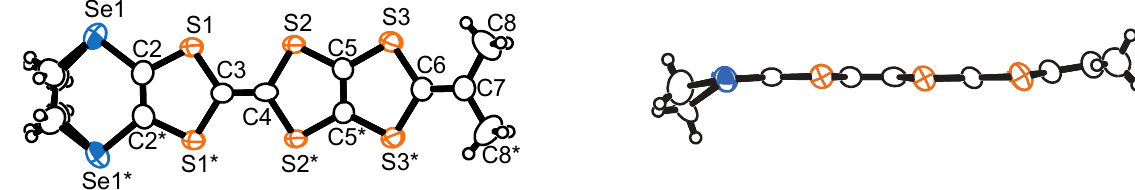
Figure 4. Top view (left) and side view (right) of ORTEP drawings of the MeDTES molecule in 4 . Displacement ellipsoids are drawn at the 50% probability level. Symmetry operator * is x , 0.5 − y , z . C8